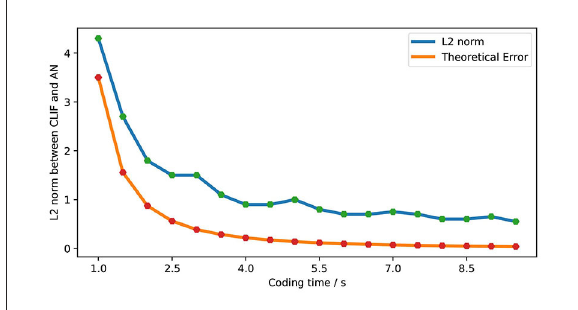
FIGURE18 Comparison of theoretical error and actual